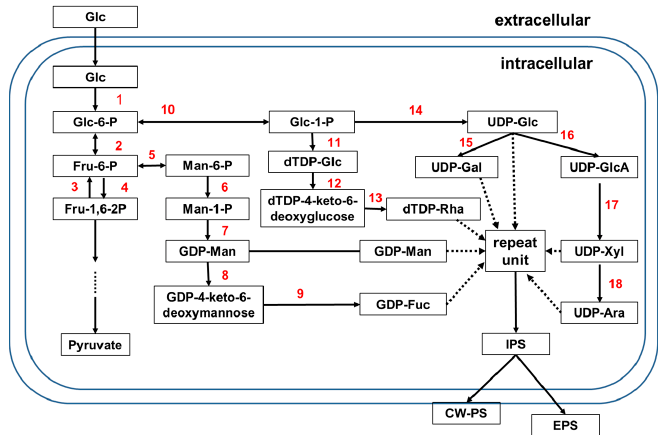
Figure 1. Proposed/deduced/hypothesized biosynthetic pathways for mushroom PSs. 1. Glucokinase (GK); 2. Phosphoglucose isomerase (PGI); 3. Fructose-1,6-biphosphatase (FBPase); 4. Phosphofructokinase (FPK); 5. Phosphomannose isomerase (PMI); 6. Phosphomannose mutase (PMM); 7. GDP-Man pyrophosphorylase (GMP); 8. GDP-Man dehydratase (GMD); 9. GDP-4-keto-6-deoxymannose epimerase/reductase (GMER); 10. Phosphoglucose mutase (PGM); 11. dTDP-glucose